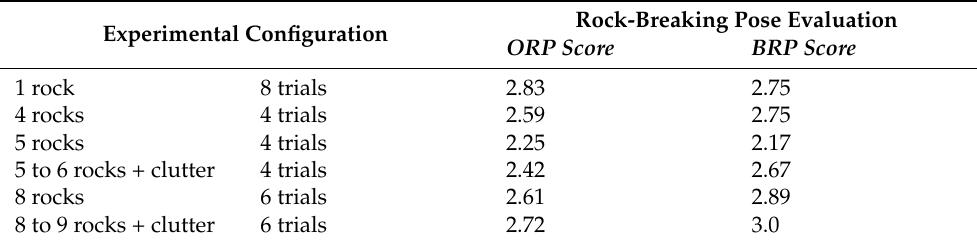
Table 3. Summary of the performance metrics for the target poses’ quality. ORP score: Overall Rock-breaking Pose score. BRP score: Best Rock-breaking Pose